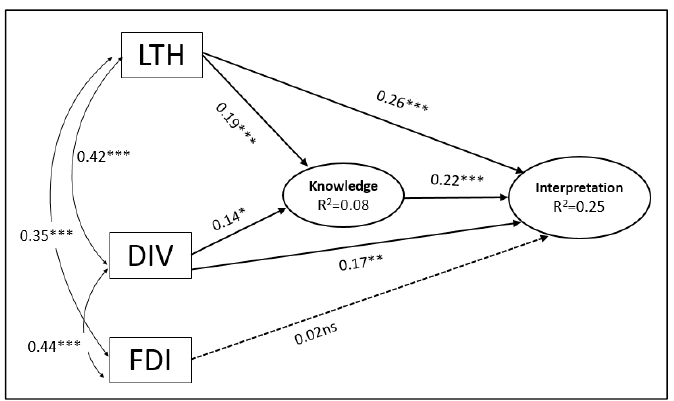
Figure 1. Path analysis for students’ performance (* p < 0.05, ** p < 0.01, *** p < 0.001).